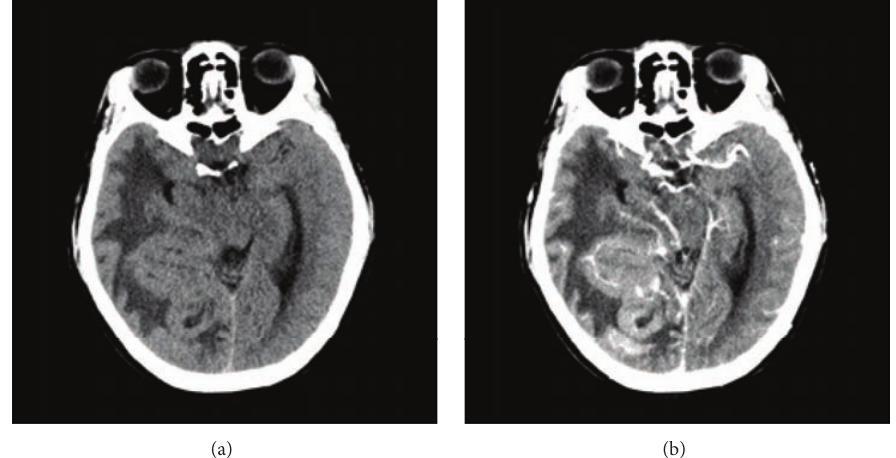
Figure 1: Axial CT images showed a cerebriform and irregular isodense mass with prominent perilesional vasogenic edema (a-b) in the right parietal-occipital-temporal region.